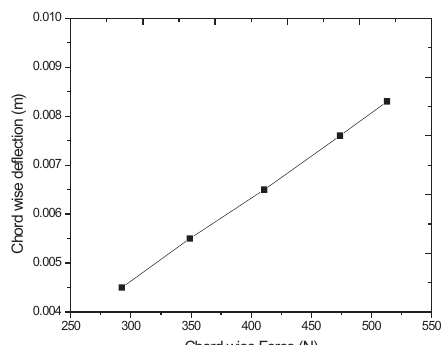
Figure 11. Twist about span axis with and without centrifugal force